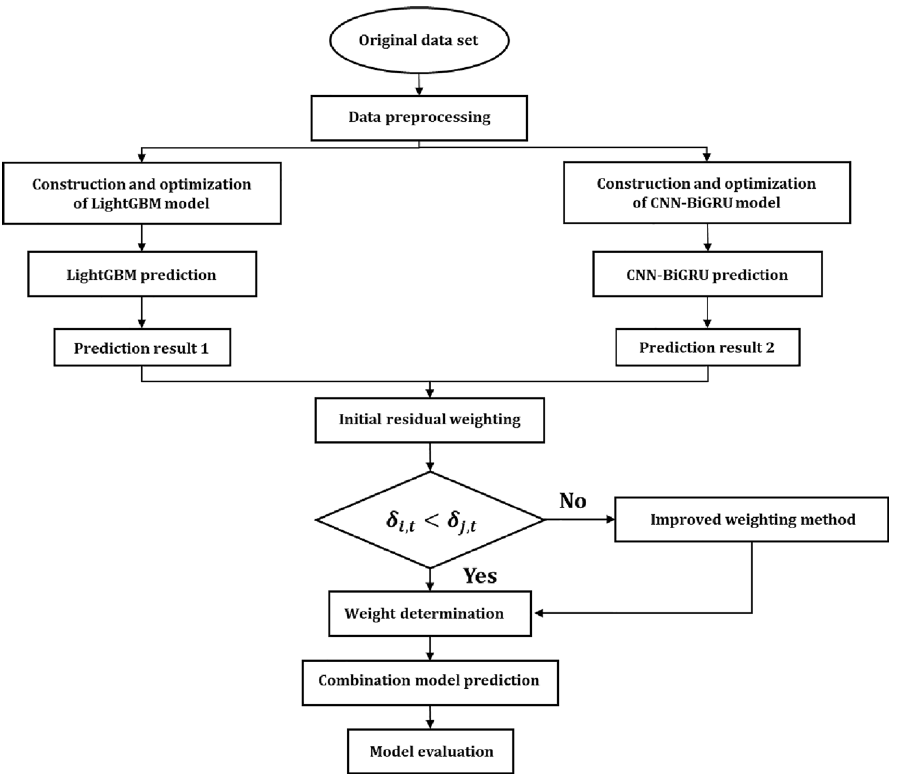
Figure 9. Prediction flow of the LightGBM-CNN-BiGRU variable weight combination